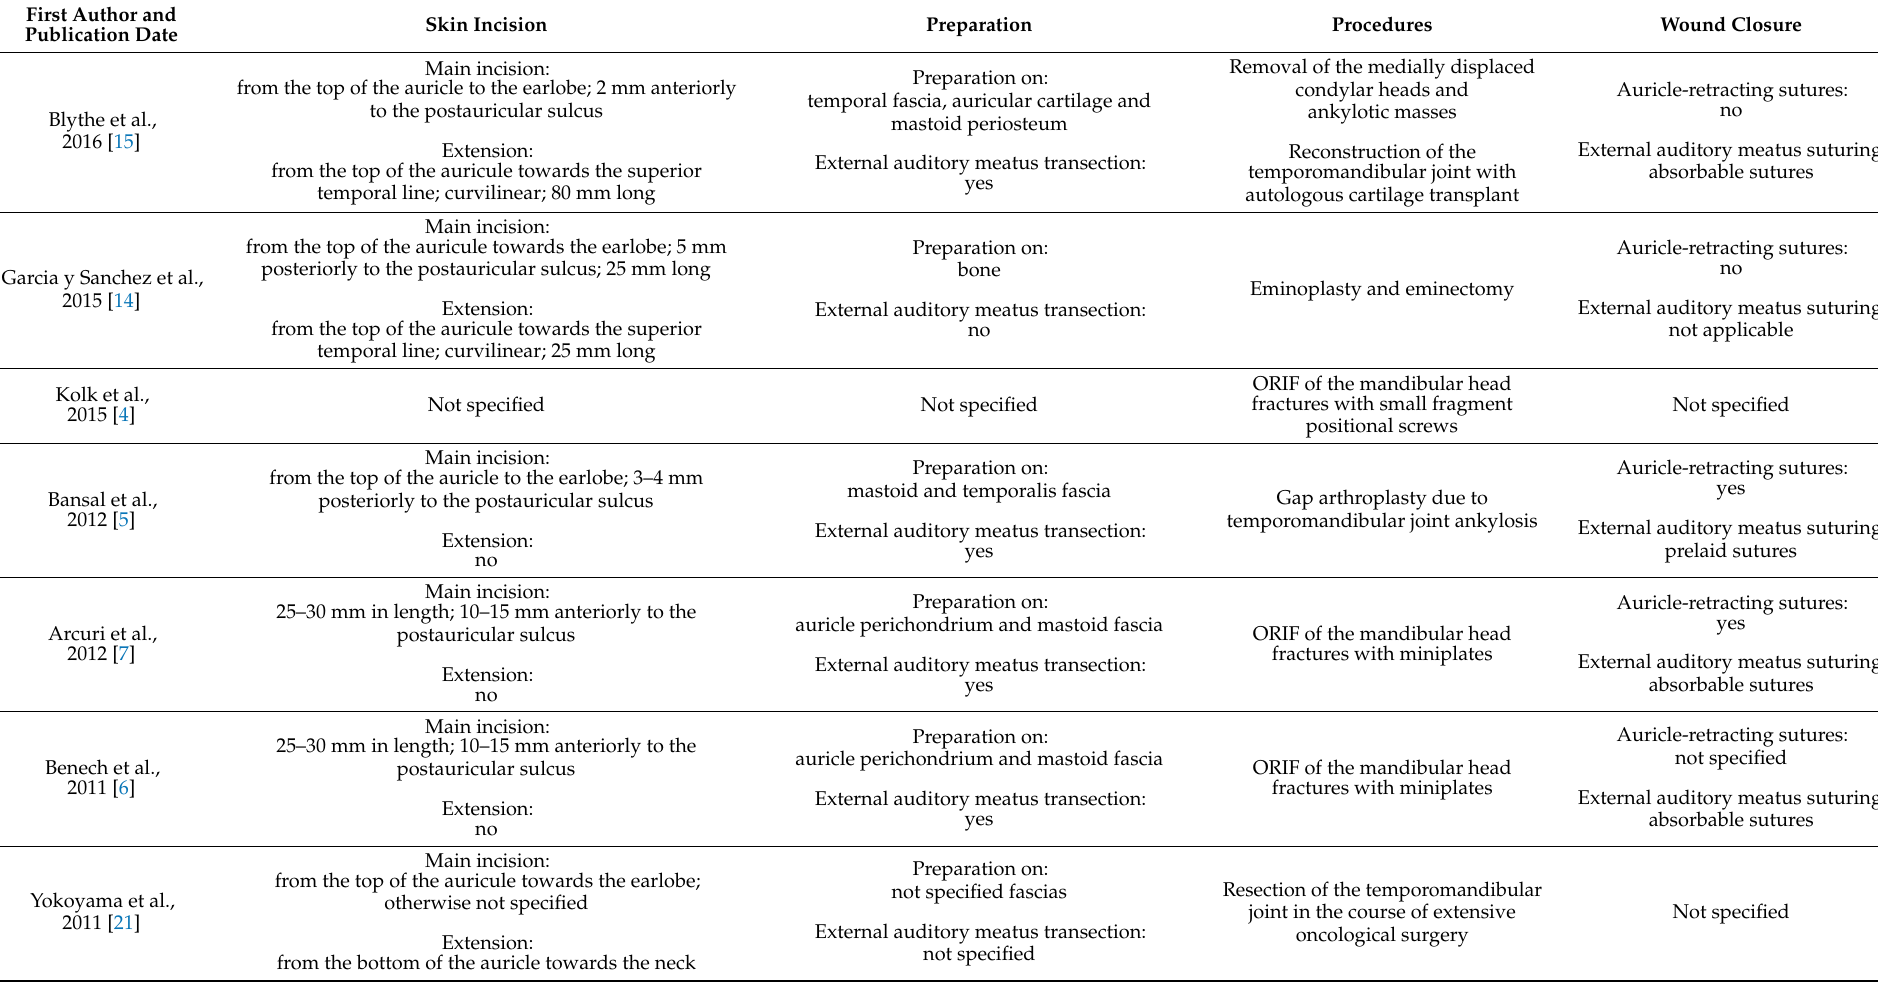
Table 5. Comparison of surgical techniques presented in individual